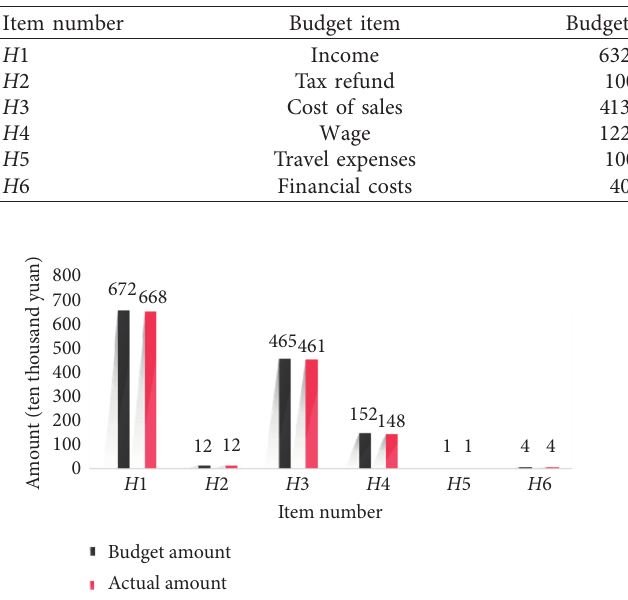
Table 4: Comparison of capital budget before system use.